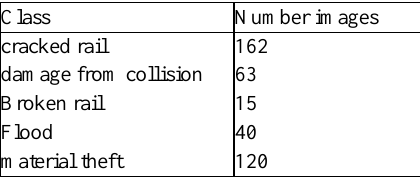
Table 2. Data distribution by classes